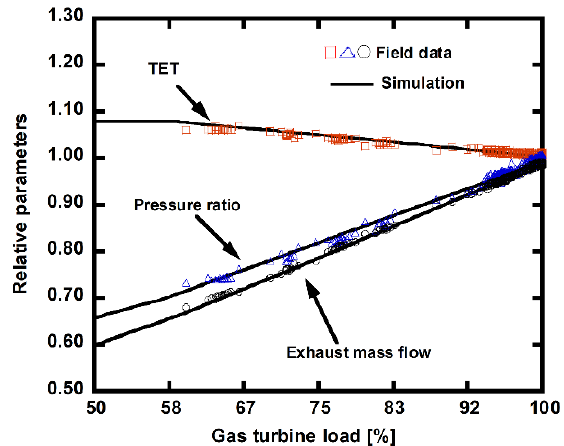
Figure 5. Variation in gas turbine parameters with load: comparison between simulation and field data.